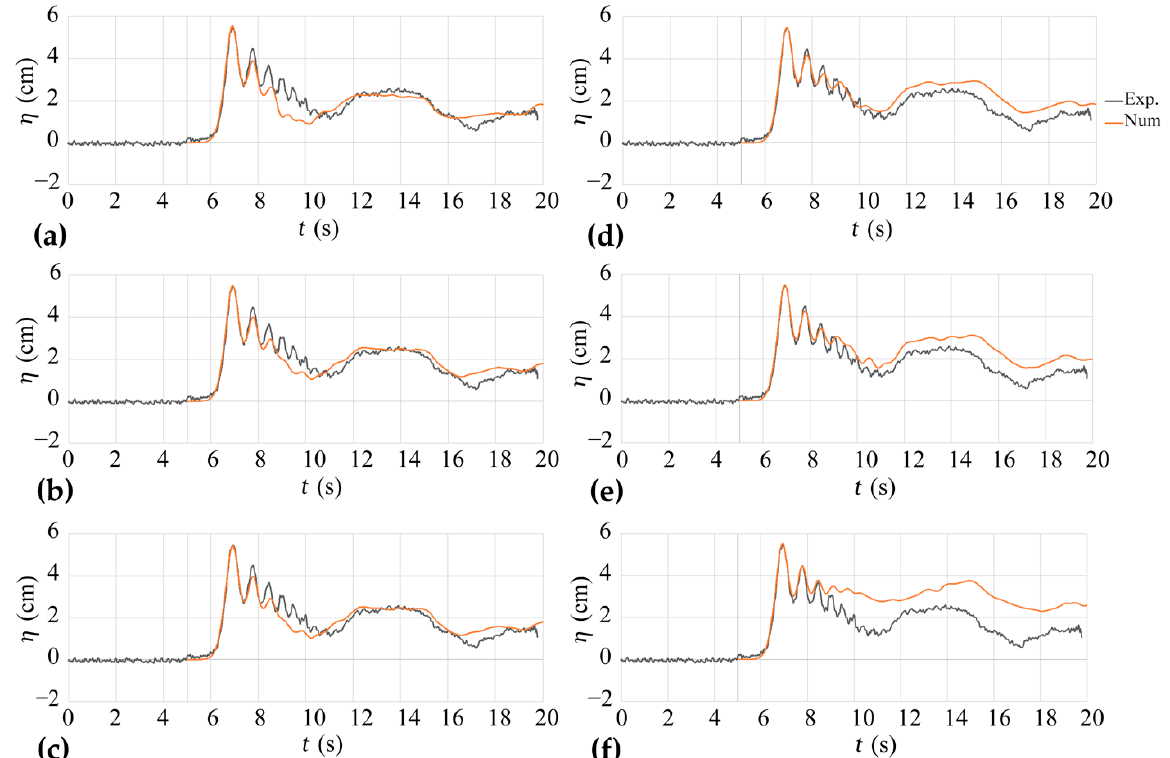
Figure 8 . Comparison of water surface elevation between numerical simulation results obtained from the FS3M and experimental data obtained from Tomita et al. [18]. ( a ) Wave height: 0.083 m and wave period: 13.0 s; ( b ) 0.082 m and 14.4 s; ( c ) 0.081 m and 14.4 s; ( d ) 0.081 m and 17.0 s; ( e ) 0.081 m and 19.0 s; and ( f ) 0.081 m and 22.0 s.